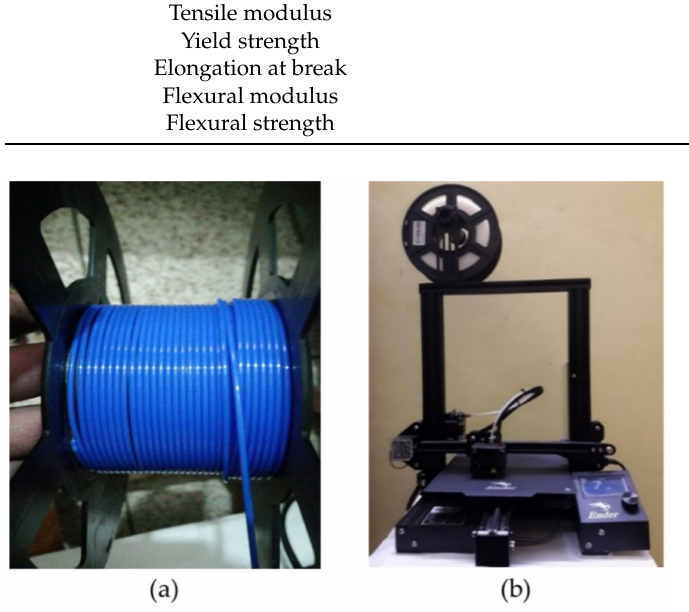
Figure 3. Machine and material: ( a ) PLA material; ( b ) Ender 3